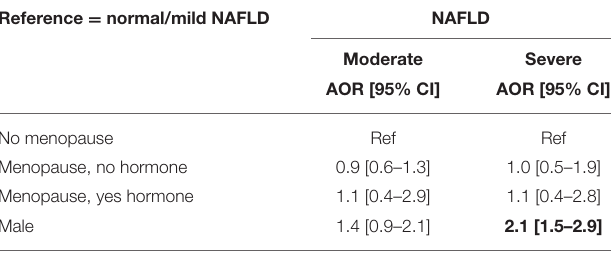
TABLE 5 | Adjusted odds ratio (AOR) and 95% confidence interval (CI) of the association between NAFLD stage and gender. Reference = normal/mild